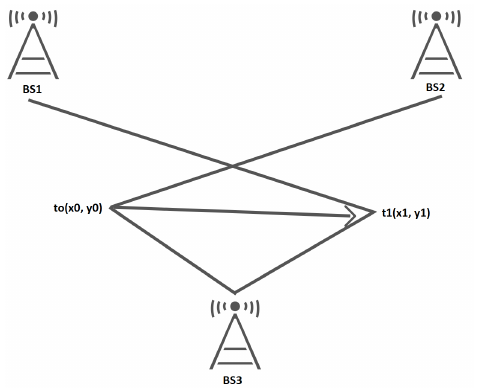
Figure 4. To calculate the direction of the robot, we computed the coordinates according to the Received Signal Strength Indicator (RSSI) levels x0, y0, x1 and